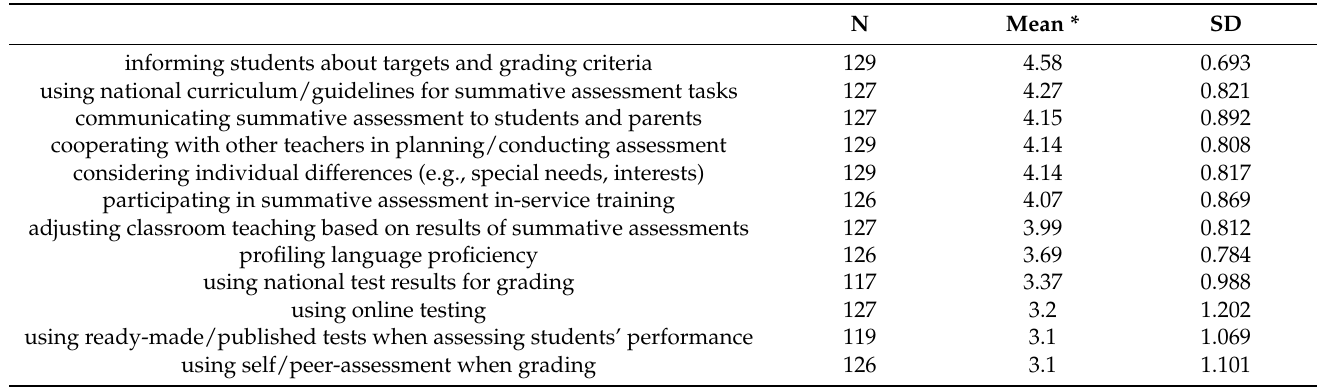
Table 3. Pre-service teachers’ perceived importance of summative assessment practices.